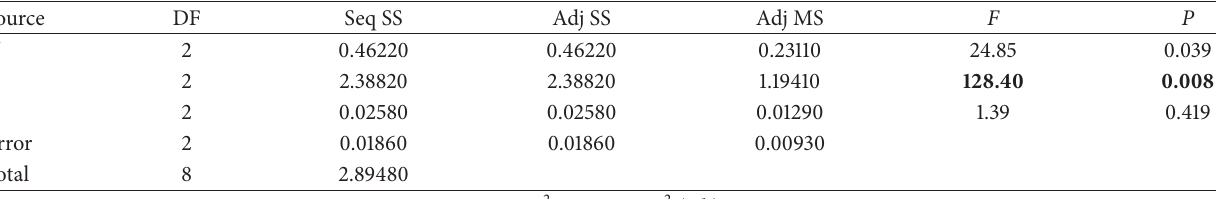
Figure 4: (a) Wear surface of Al6061/12 wt.% Al 2 O 3 /6 wt.% MoS 2 tested at 15 N load. (b) Wear surface of Al6061/12 wt.% Al 2 O 3 /6 wt.% MoS 2 tested at 45 N load. Table 13: Analysis of variance for Ra of Al6061/12 wt.% Al 2 O 3 /6wt.% MoS 2